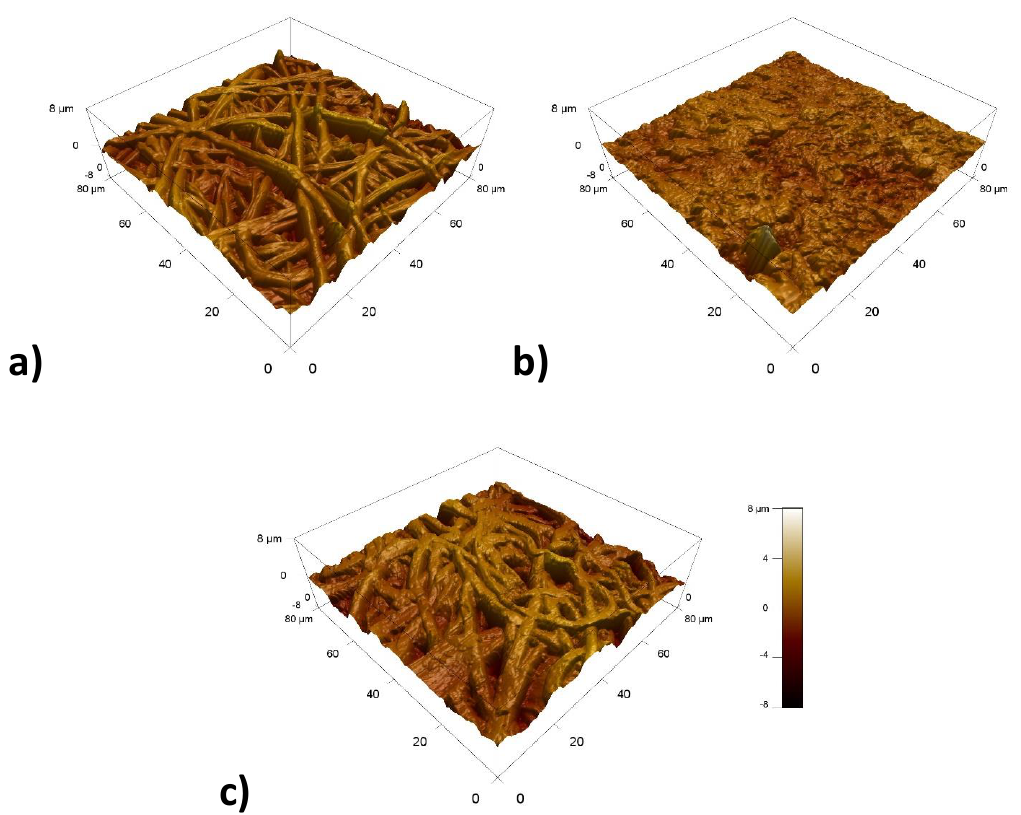
Figure 5. AFM images of ( a ) the neat coPA mat, ( b ) the coPA membrane covered by ML-Ti 3 C 2 T x and ( c ) the coPA membrane covered by SL-Ti 3 C 2 T x.